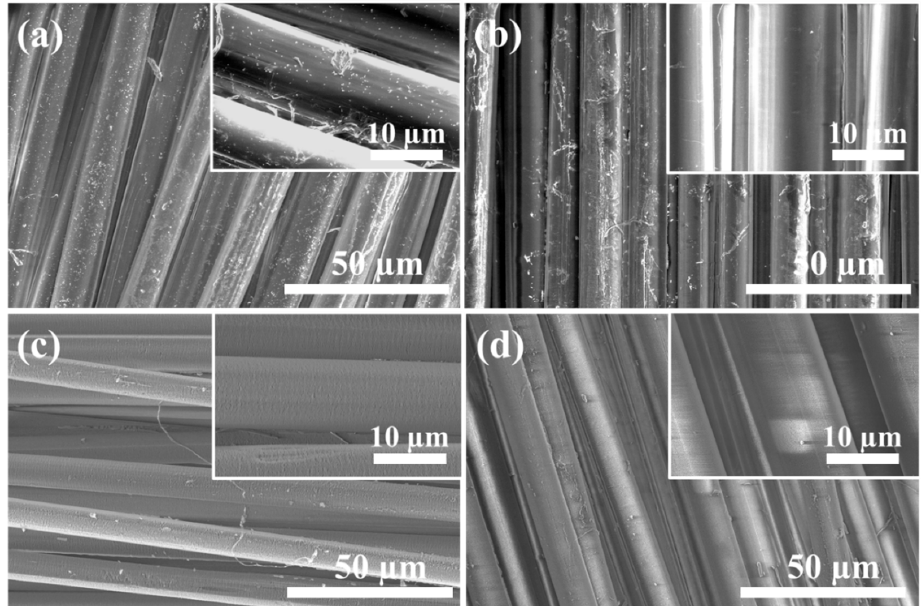
Figure 2. SEM images of PPTA fabric without treatment ( a ) and with oxygen plasma treatment for 1 min ( b ), 5 min ( c ) and 10 min ( d ). The insets show magnified images.